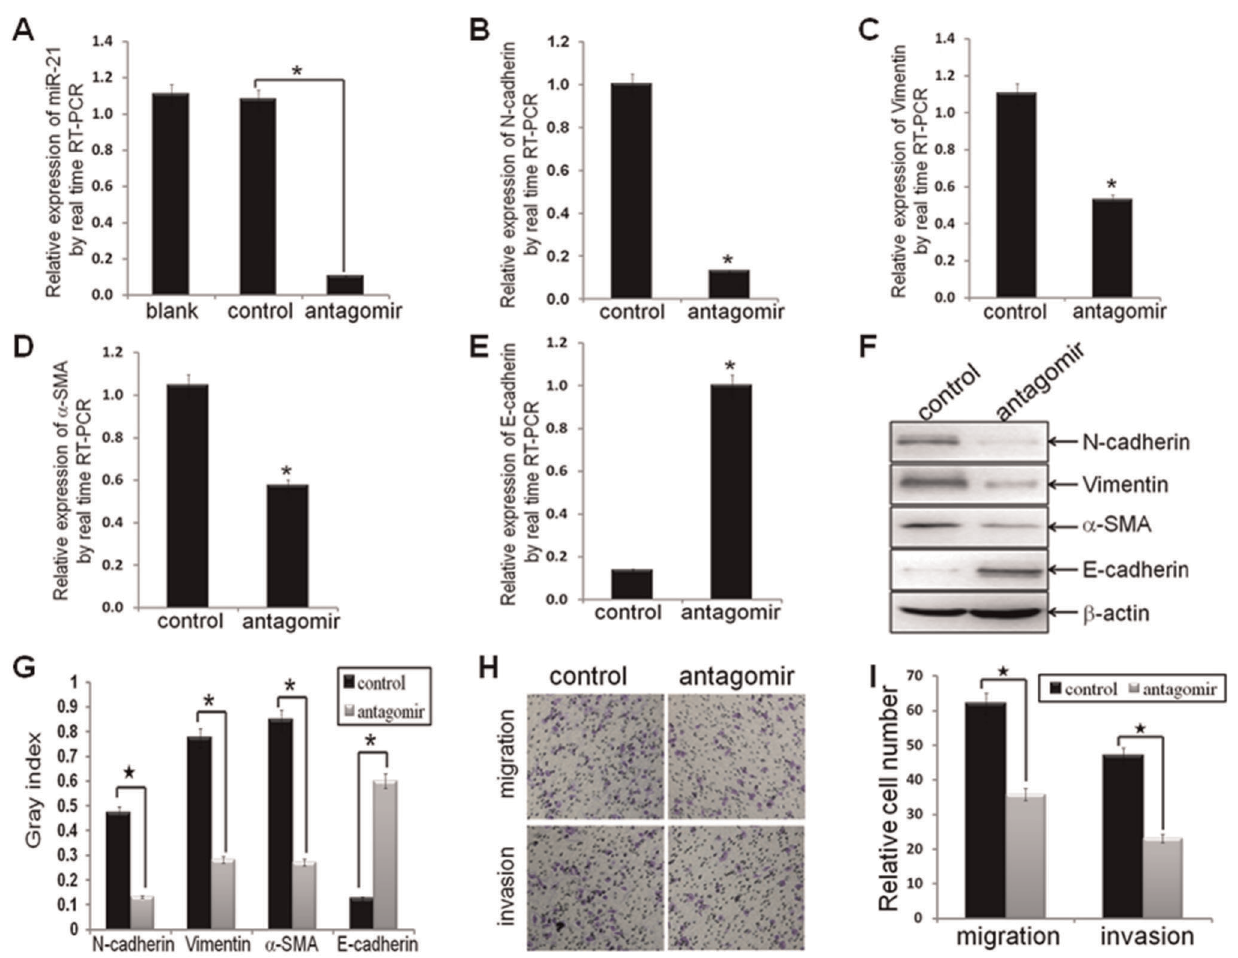
Figure 1. Antagonism of miR-21 reversed EMT phenotype, as well as decreased cell migration and invasion. MDA-MB-231 cells were transfected with hsa-miR-21 antagomir or hsa-miR-21 antagomir control at a final concentration of 50 nmol for 48 h. (A) MDA-MB-231 cells were treated with hsa-miR-21 antagomir decreased the expression of miR-21, as compared to control groups (n1=n2=3; p=0.0015), by real-time RT-PCR analysis. (B-E) The mRNA levels of mesenchymal biomarkers (N-cadherin, Vimentin and alpha-SMA) and epithelial biomarker (E-cadherin) in MDA-MB- 231/anti-miR-21 cells and MDA-MB-231/control cells, as measured by real-time RT-PCR analysis. The real-time RT-PCR reactions were performed in a 20 m l reaction volume in triplicate, simultaneously. (F, G) The relative protein levels of EMT markers in indicated cells were shown by Western blot analysis, and bands were semi-quantified using ImageJ software. Beta-actin was used as loading control. (H, I) The migratory and invasive properties of indicated cells were tested in migration and invasion assay in Transwell inserts. Penetrated cells were counted and analyzed in histogram. Data represent at least three experiments done in triplicate. (*indicates p , 0.05; w indicates p , 0.001).